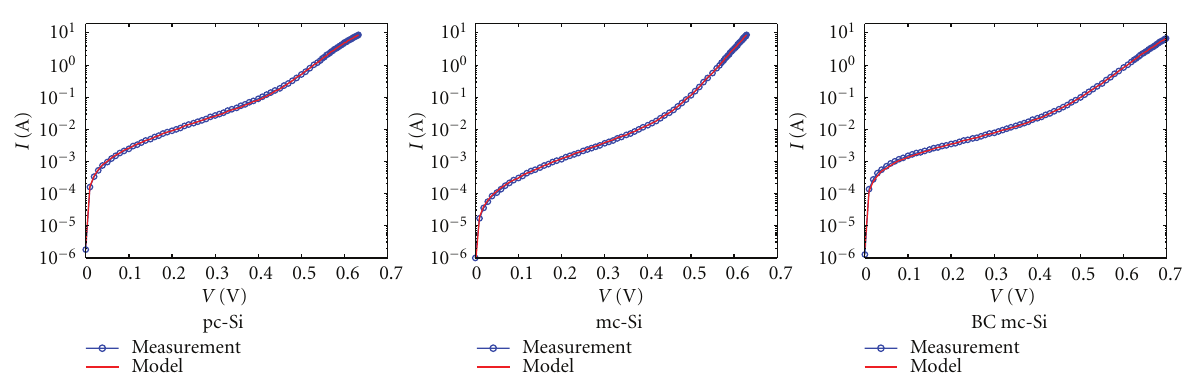
Figure 4: Alignment between modelled and measured I-V curves of selected solar cells shown in semilogarithmic scale.